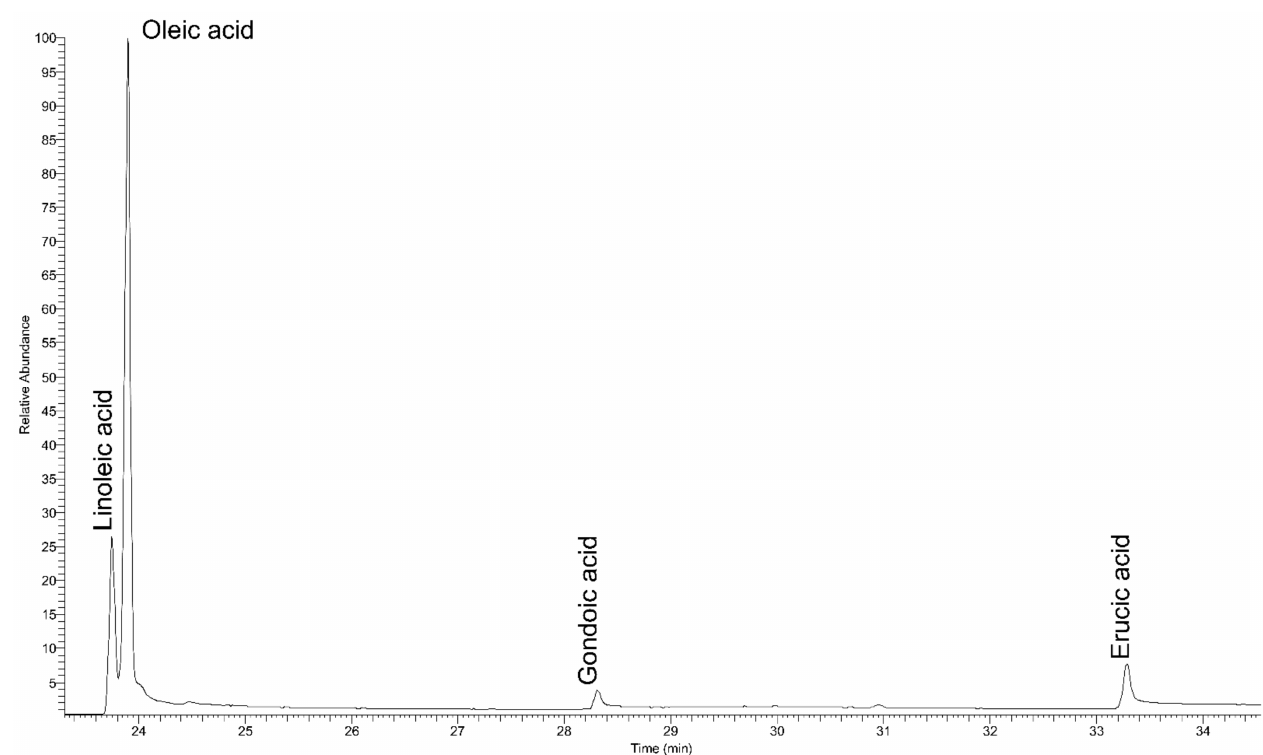
Figure 5. Total ion current chromatogram of the acidic fraction of fresh radish